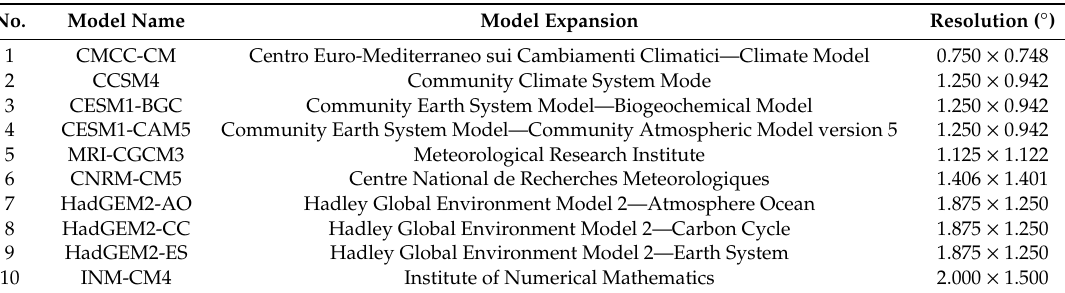
Table 2. Global climate models (GCMs) used for the